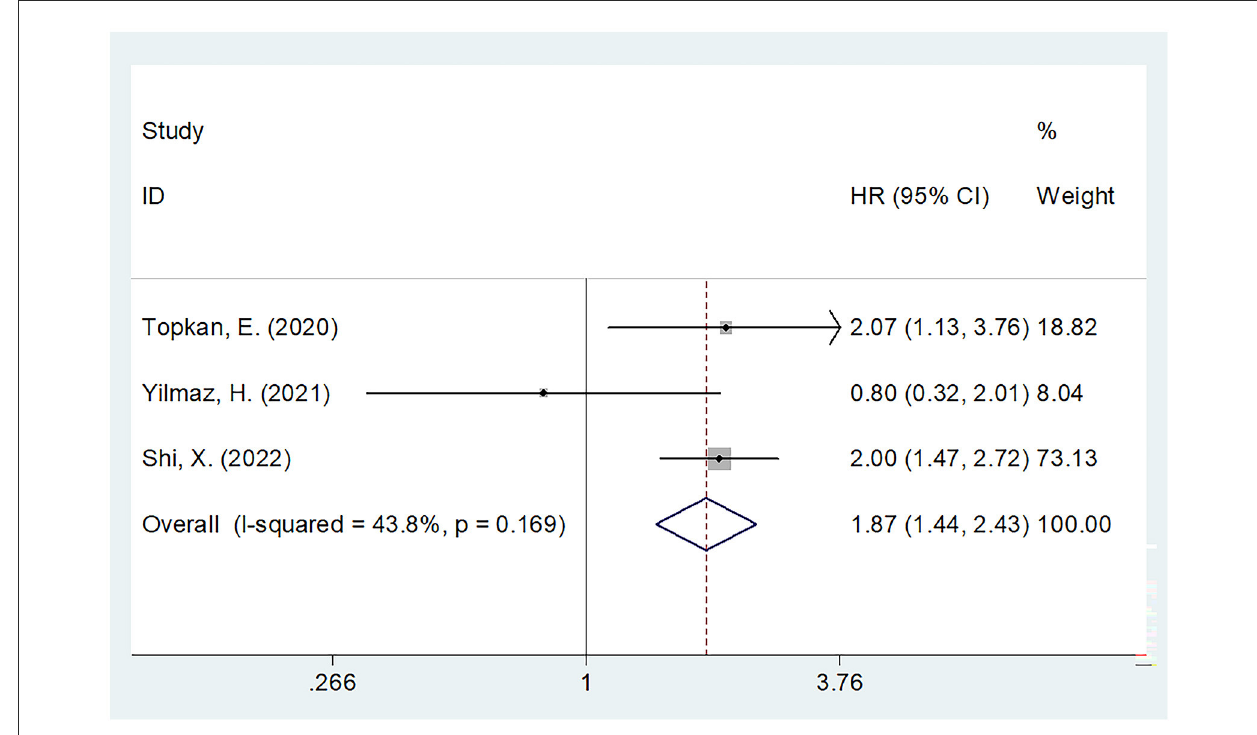
FIGURE3 Forest plot of the association between the SII and progression-free survival of glioma.